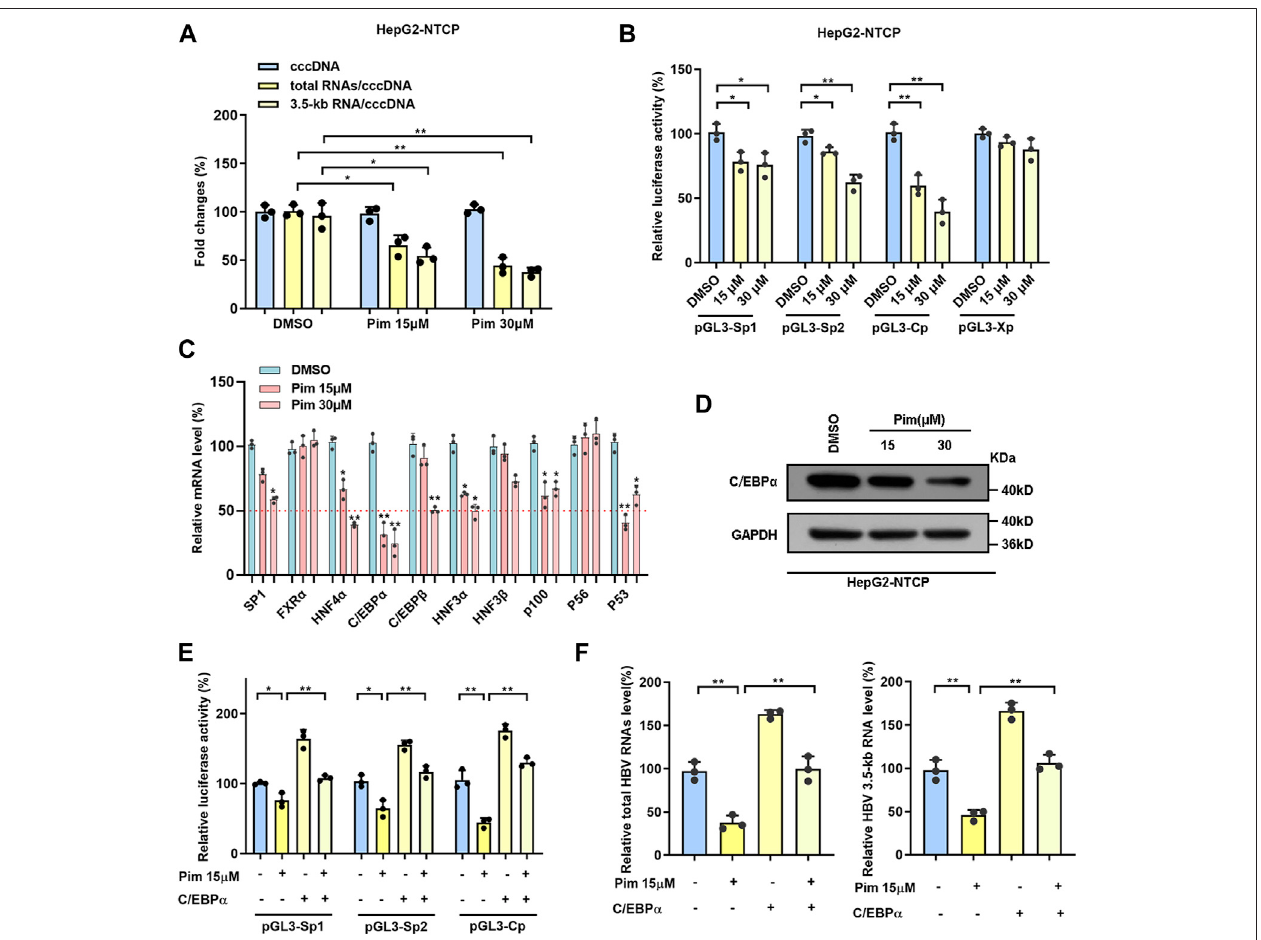
FIGURE 5 | Pim regulated cccDNA transcription related to transcription factors (A) The ratios of total HBV RNAs/cccDNA and HBV 3.5-kb RNA/cccDNA were reducedinadose-dependent manner (B) Theactivities offourHBVpromotersweredetectedbydual-luciferasereporterassaysystemafterPimtreated48 hinHepG2- NTCP cells (C) The mRNA level of transcription factors related toHBV Sp Ⅰ , Sp Ⅱ and core promoters were detected in HepG2-NTCP byRT-PCR after Pim treatment (D) The change of protein level of C/EBP α was identi fi ed by Western blot in HepG2-NTCP (E) The luciferase report plasmids (pGL3-Sp Ⅰ , pGL3-Sp Ⅱ and pGL3-Cp) were transfected into HepG2-NTCP cells, accompanied by C/EBP α overexpression plasmid or not. 12 h after transfected, the cells were treated with 15 μ M Pim as indicated for 48 h. The activities of HBV promoters were detected (F) The levels of total HBV RNAs and HBV 3.5-kb RNA were detected after Pim treating or C/EBP α overexpressing by qPCR (* p < 0.05; ** p <